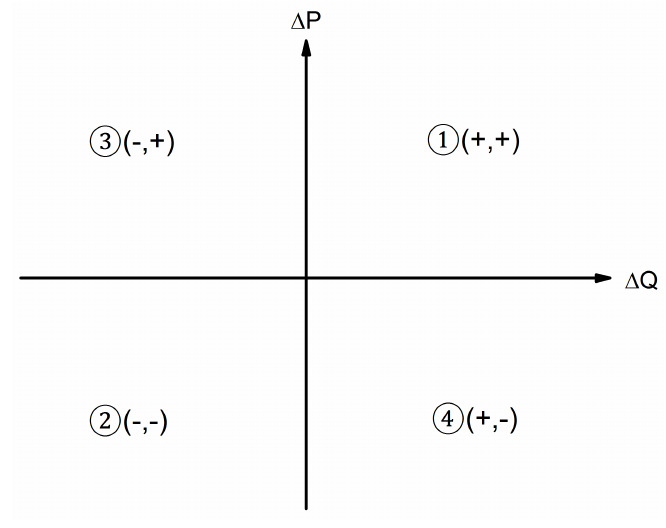
Figure 2. Four states of change in pressure and flow.